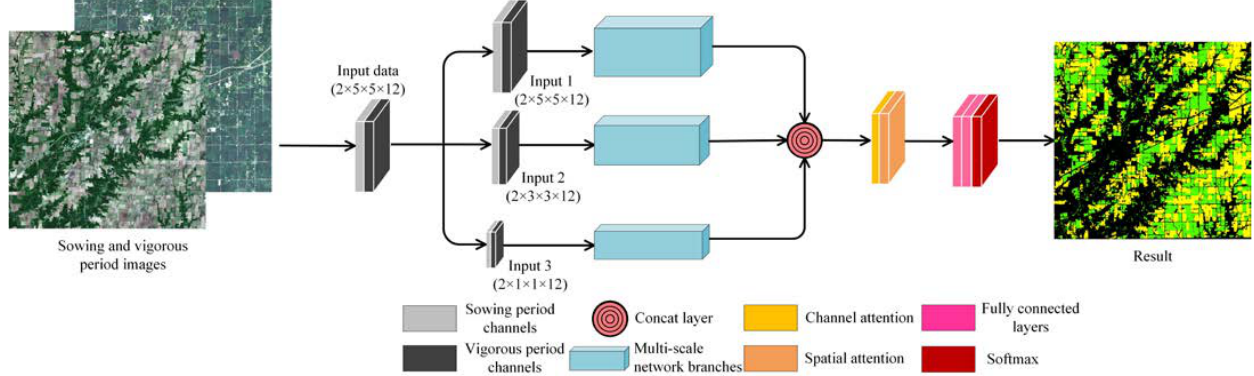
Figure 3. The structure of our MACN.